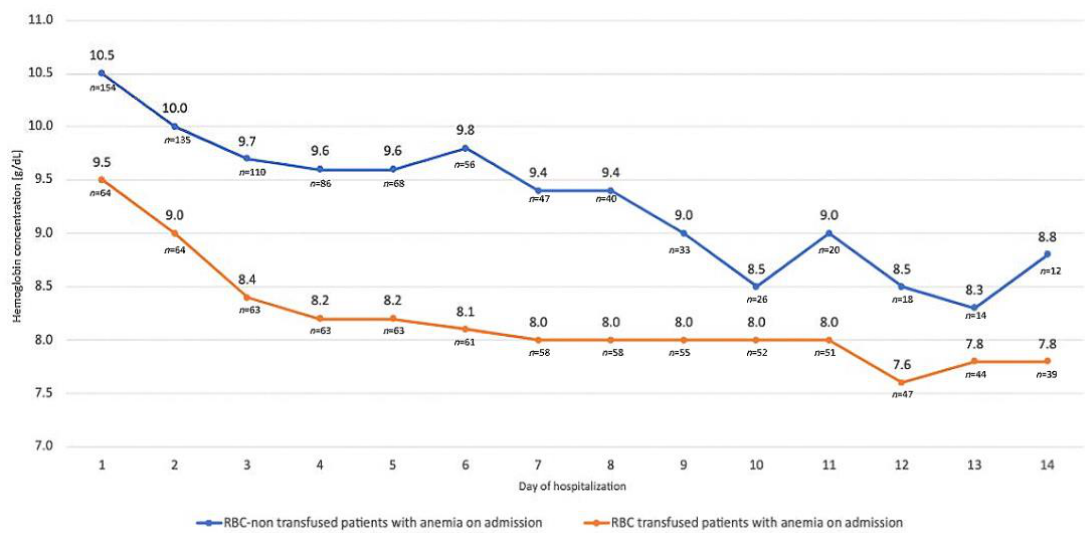
Figure 1. Hemoglobin concentration during first 14 days of hospitalization in patients with anemia on admission with regard to a need for RBC transfusion.